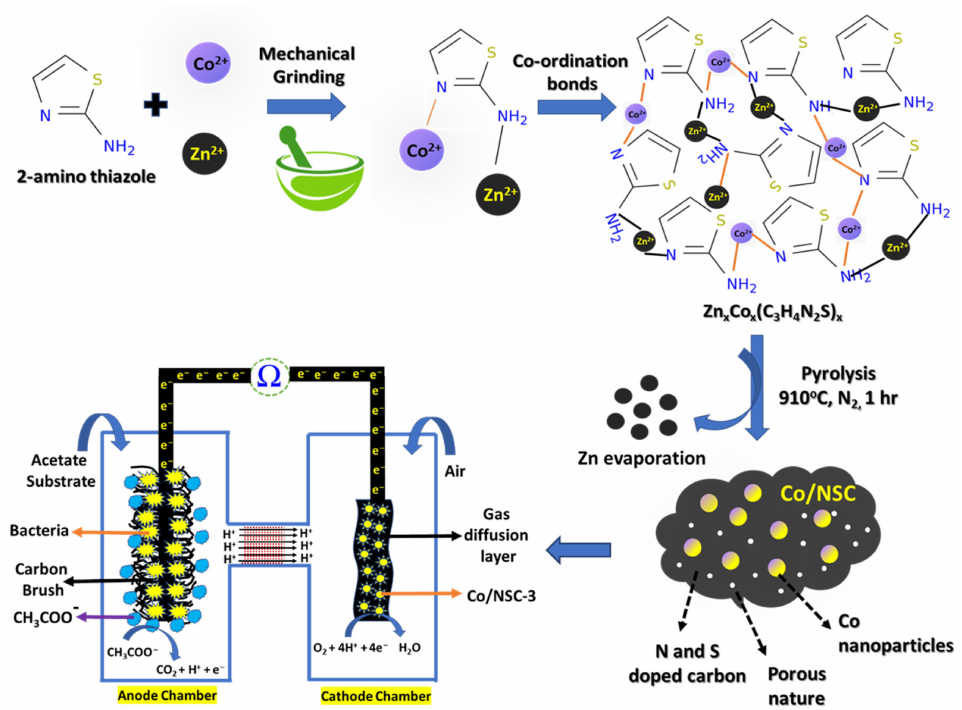
Scheme 1. Graphical representation of the Co/NSC catalyst synthesis process and its application in